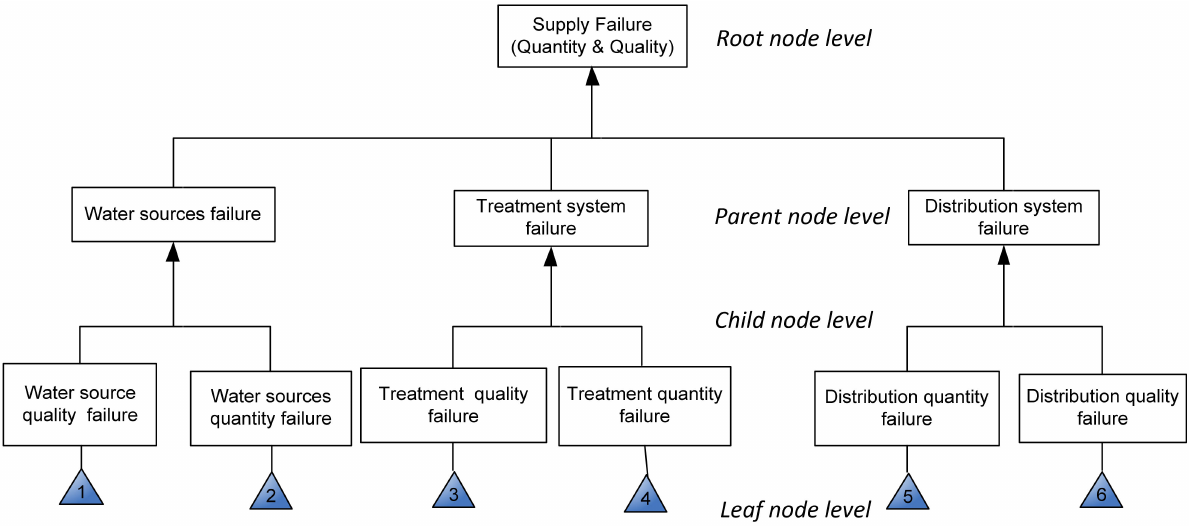
Figure 4. A hierarchical decomposition of a water supply system in “a system of systems”